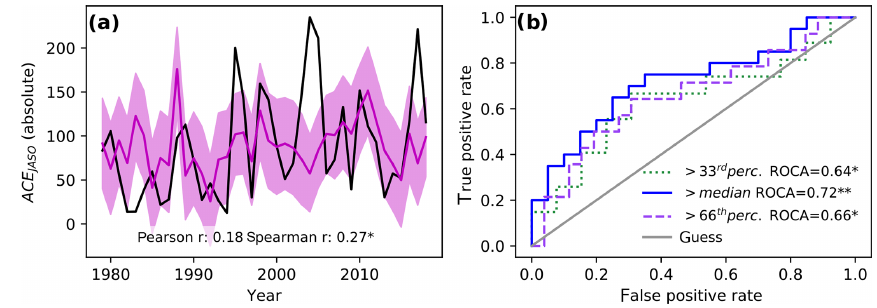
Figure 8. Hindcast skill based on March reanalysis. As Fig. 5 but for March.